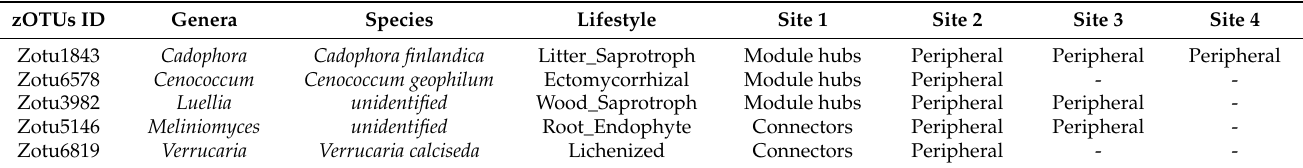
Table 4. Topological role shift between different tundra sites. Module hubs and connectors were considered as generalists whereas peripheral as